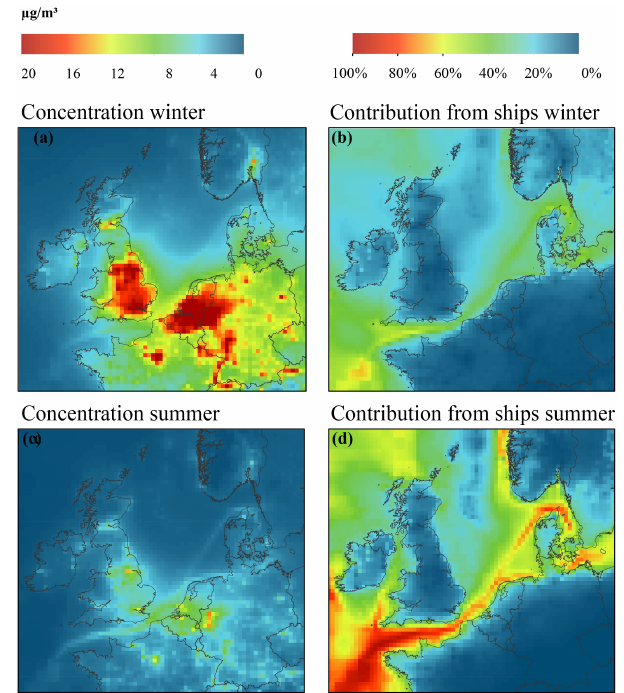
Figure 8. NO 2 in summer and winter and the relative contribution of ship emissions.